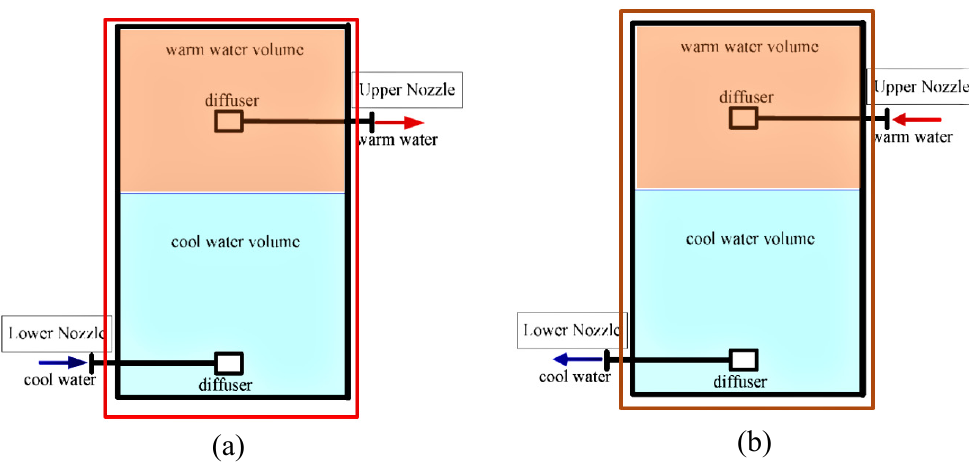
Figure 1. Charging and discharging scenario in the Thermal Energy Storage (TES) tank: ( a ) Charging, ( b ) Discharging .